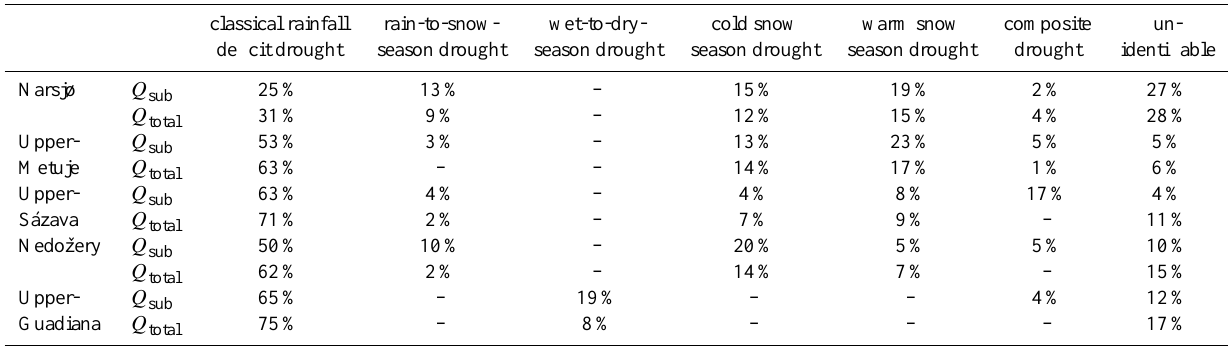
Table 5. Hydrological drought types of all hydrological drought events per catchment (subsurface runoff and total runoff).